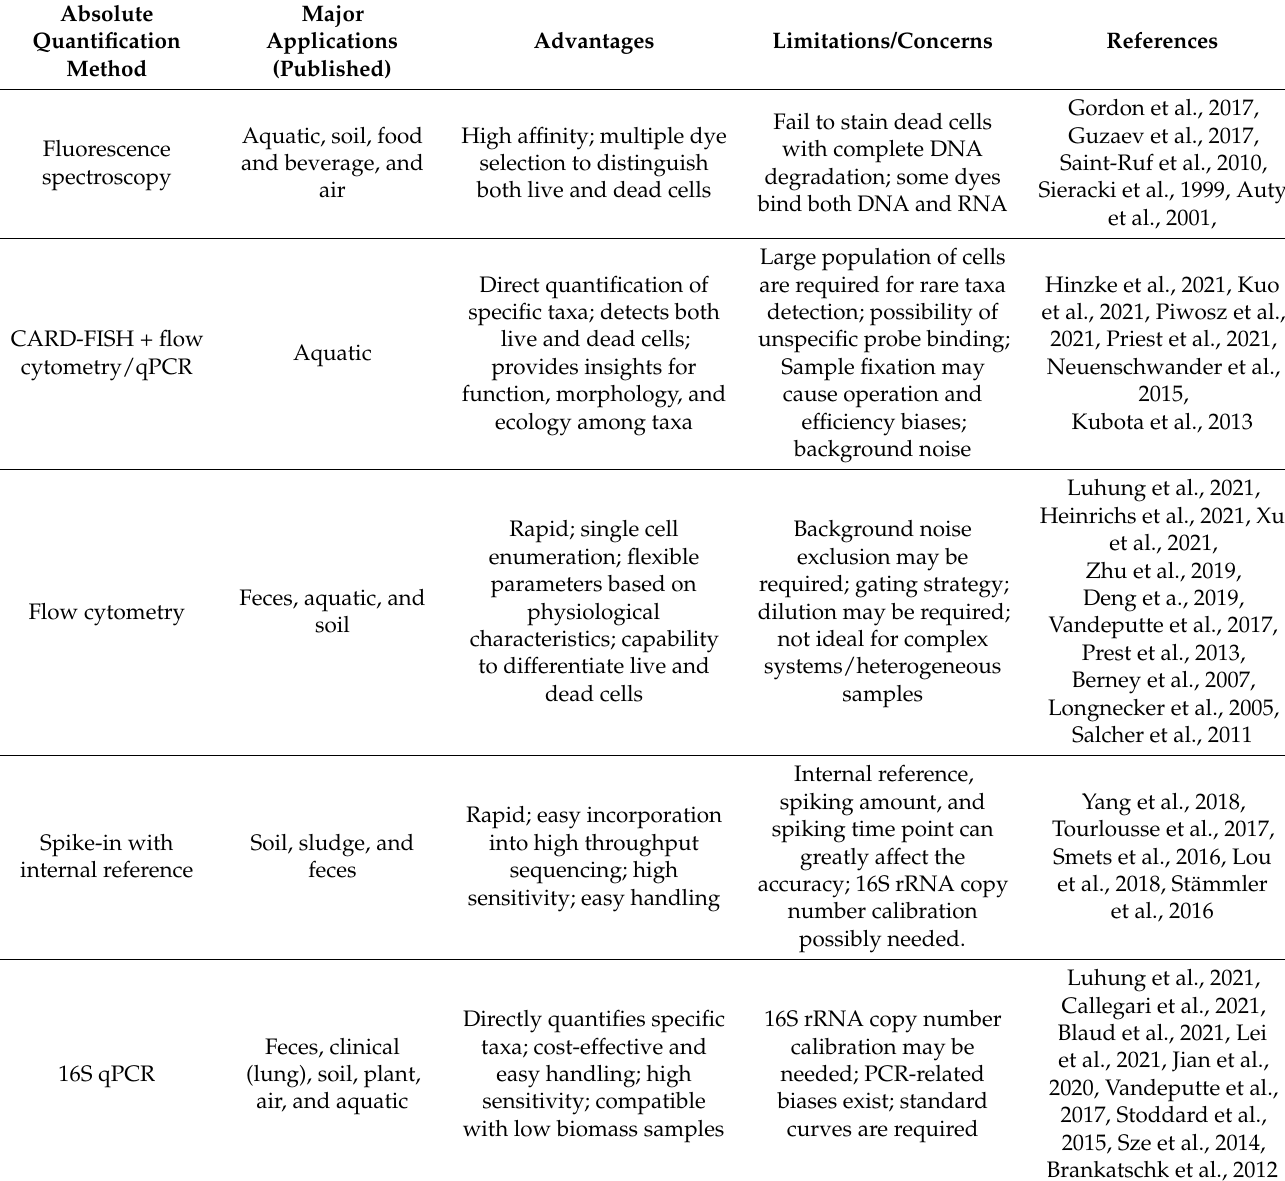
Table 1. Absolute quantification methods in microbiome